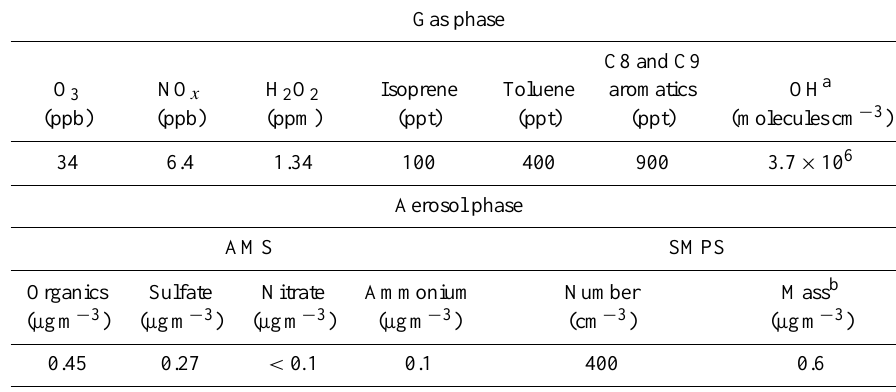
Table 2. Initial species concentration for the induced ambient nucleation experiment.